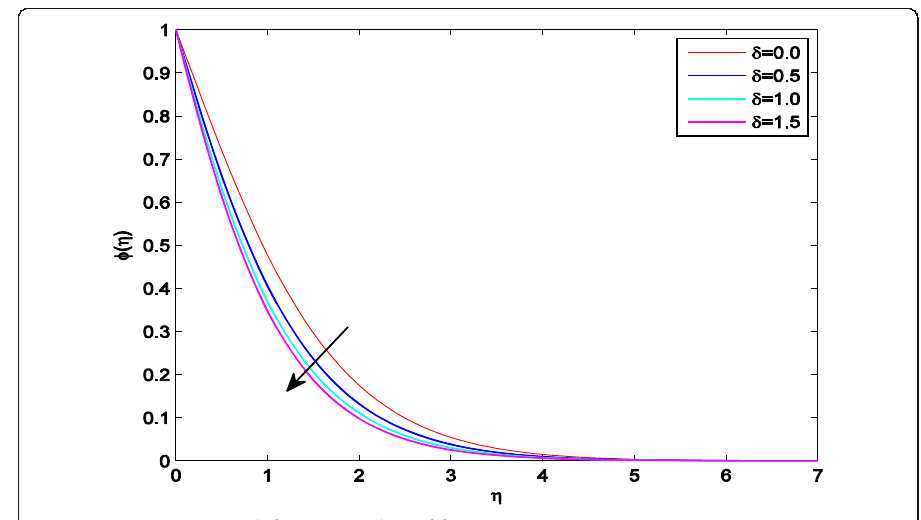
Fig. 25 Concentration graph for various values of δ